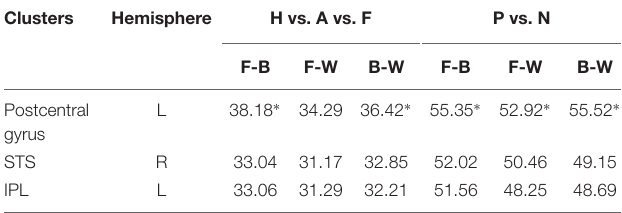
TABLE 3 | Classification accuracies from cross-modal MVPA for each searchlight